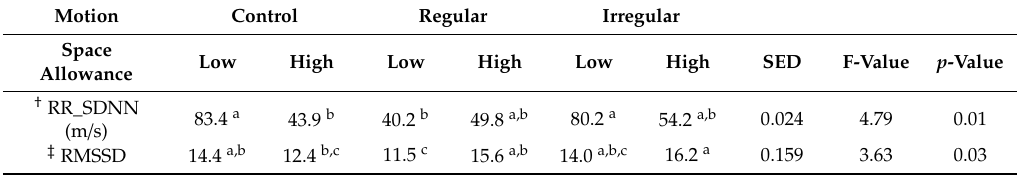
Table 5. Significant ( p < 0.05) interactions between control, regular and irregular motion treatments and space allowance on sheep ( n = 6) heart rate RR_SDNN and RMSSD in simulated ship transport. Motion Control Regular Irregular Space Low High Low High Low High SED F-Value p -Value Allowance (m /